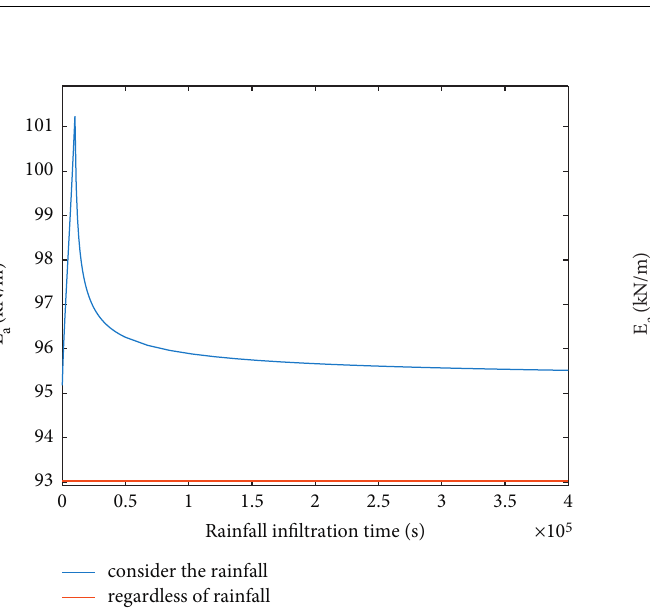
Figure 3: Variation in unsaturated sandy soil E infiltration time.